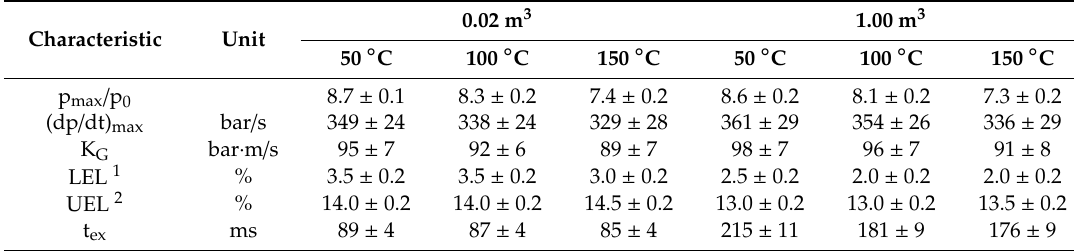
Table 4. 2-propanol explosion characteristics at Φ = 1.06, p 0 = 100 kPa.